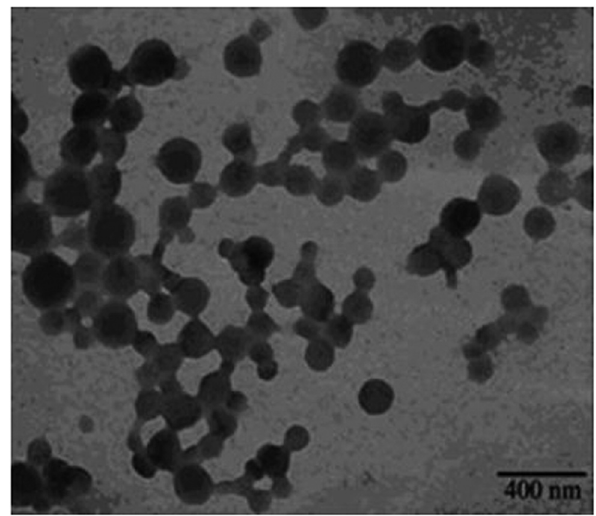
Figure 4: TEM image of nano - silica during gelation [ 65 ] .